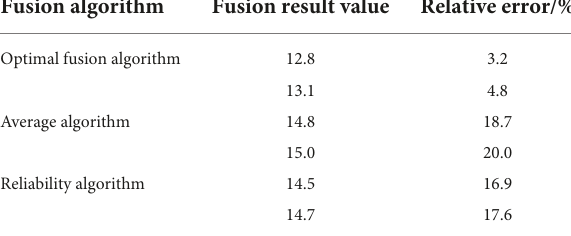
FIGURE8 Comparison of results. (A) Raw data results in the experiment. (B) Experimental results of the PGM model. (C) Experimental results of the OGM model.